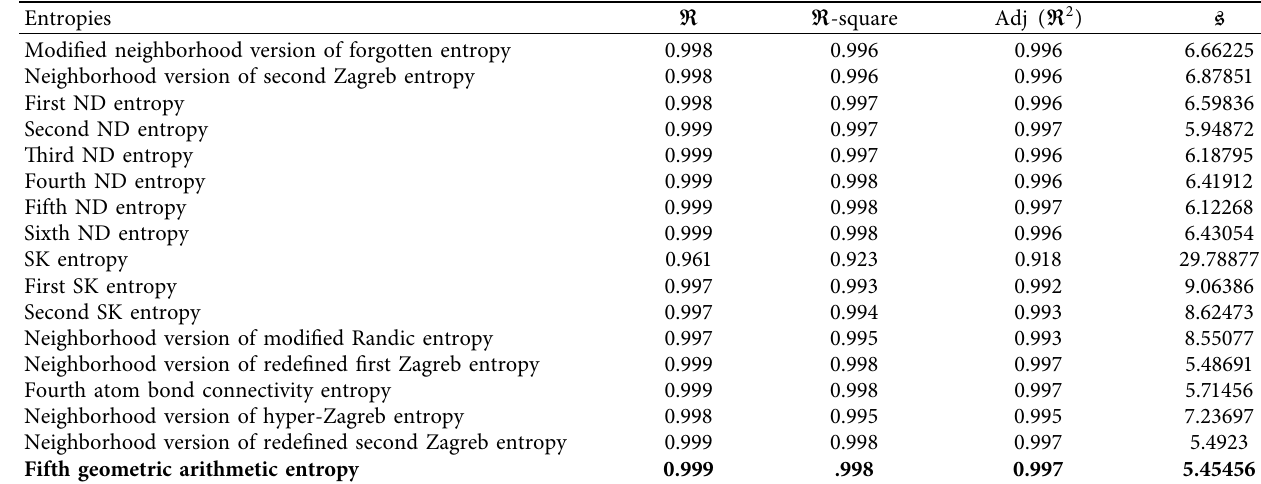
Figure 4: An illustration of benzene derivatives for the second type. Table 4: The significant LRM: critical temperature of benzene derivatives on